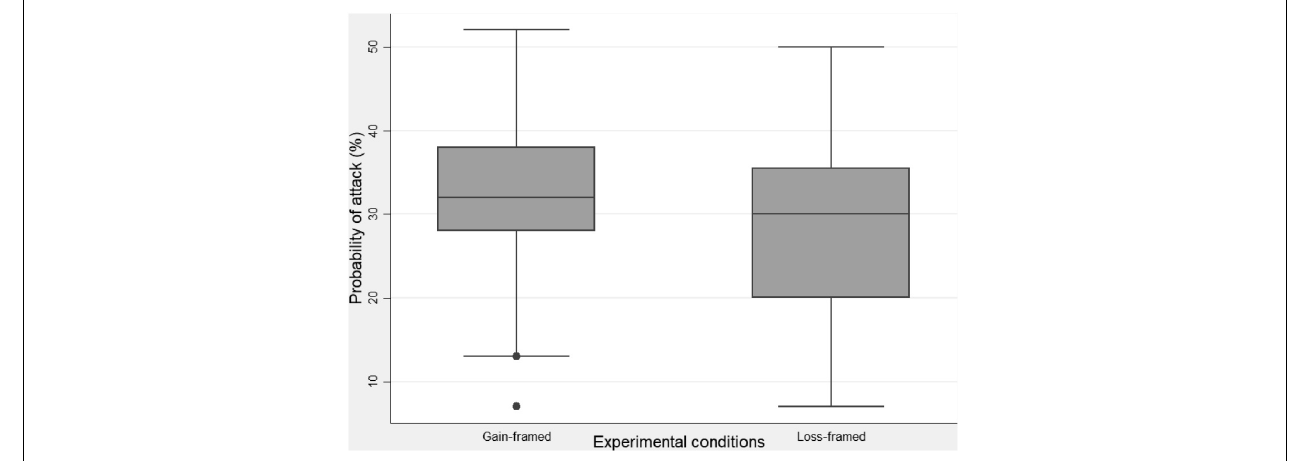
FIGURE 1 | Box-plot of the probability of suffering a cyberattack by experimental group.